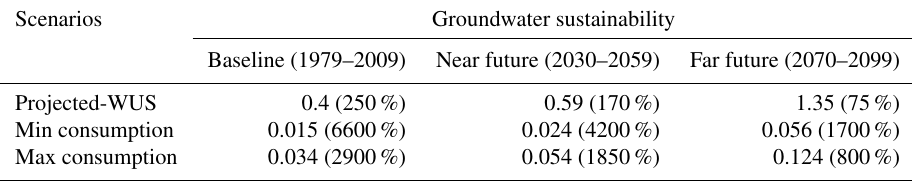
Table 8. Groundwater sustainability on the entire basin scale under three scenarios. Projected-WUS: the number of water use systems increases linearly with population growth. Minimum and maximum consumption: the minimum and maximum water demand corresponds to population growth in the future. The percentage of the water demand that can be sustainably provided by groundwater is mentioned in brackets.